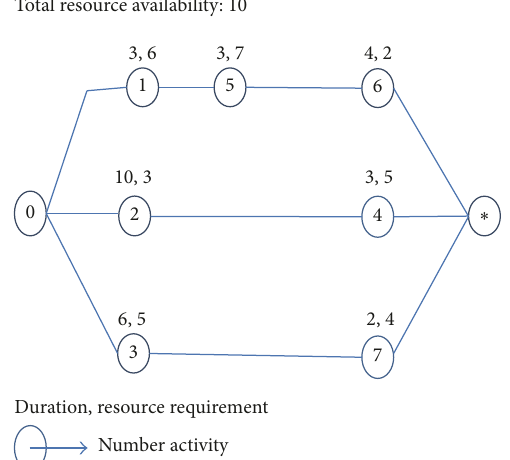
Figure 1: A sample resource-constrained project.